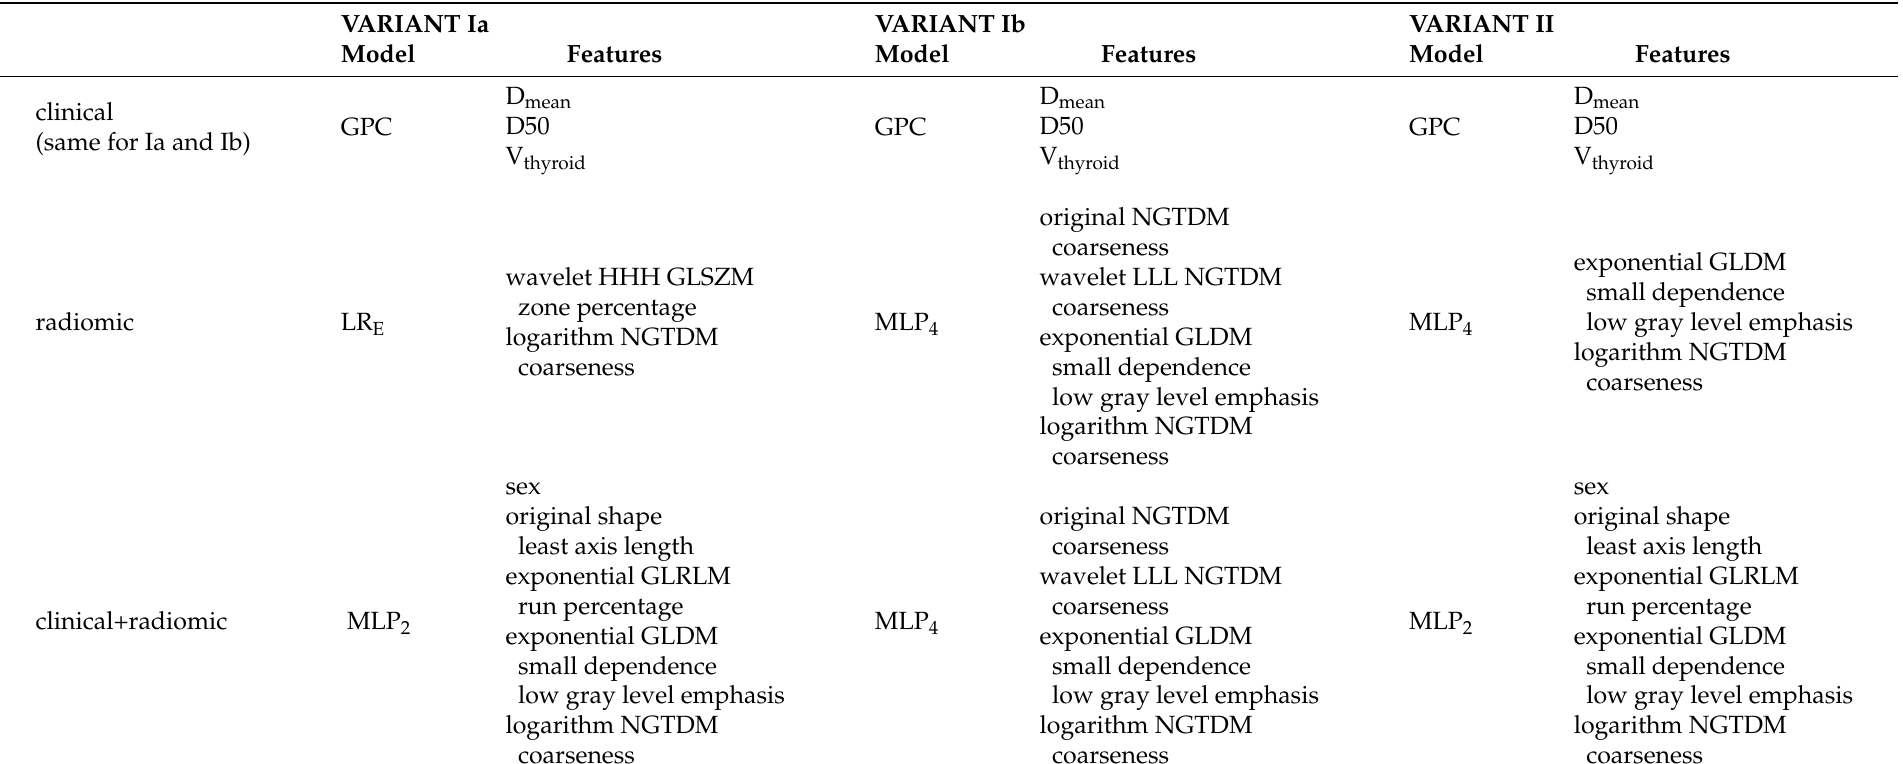
Table 2. Model architectures and features selected for each of the variants and feature